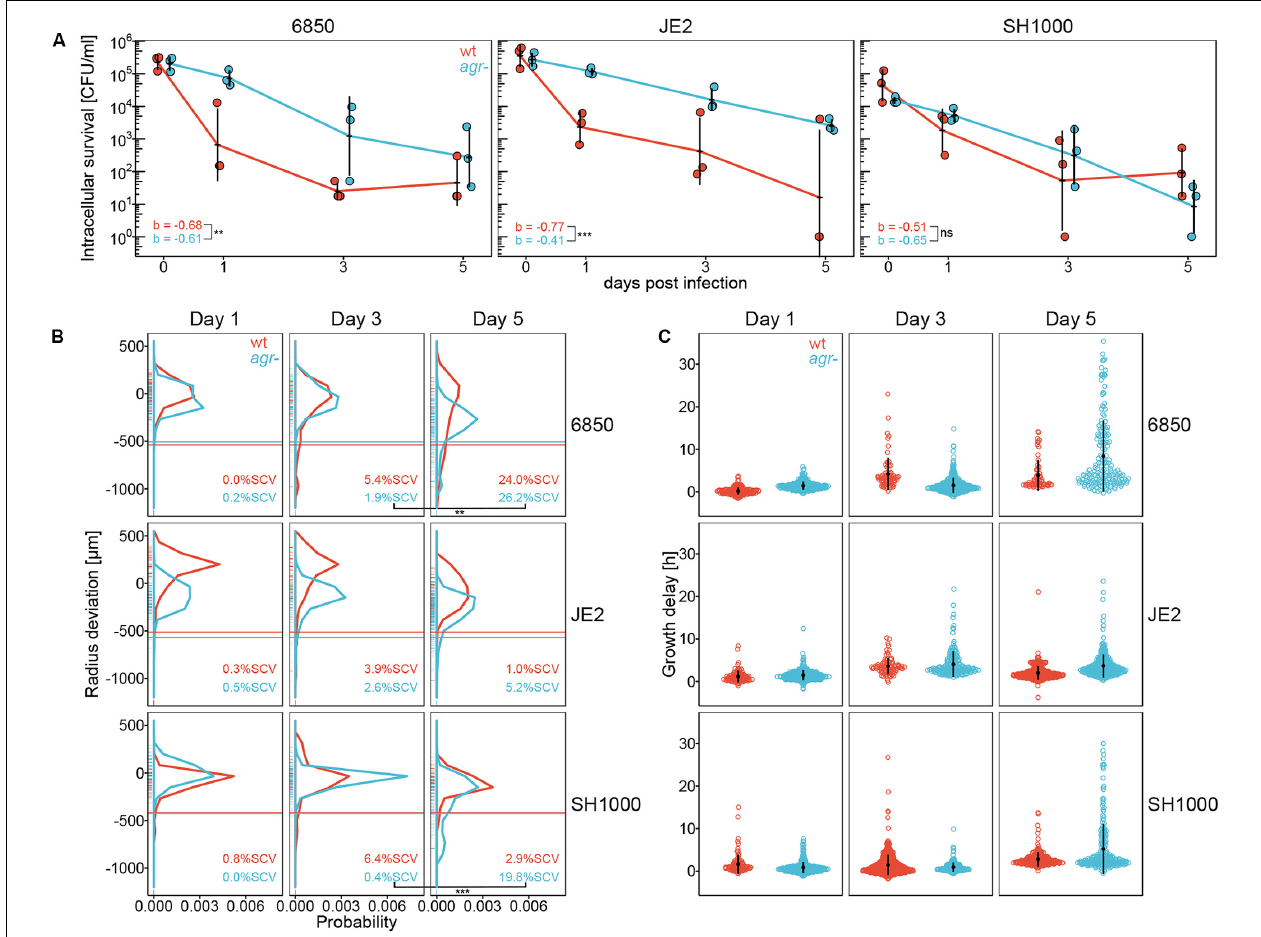
FIGURE 2 | Intracellular survival, colony size distribution and lag time of S. aureus wild type strains (wt) and agr mutants ( agr- ). S. aureus wild type strains are indicated in red, agr mutants are indicated in blue. (A) Intracellular survival of S. aureus wild type strains and agr mutants in A549 cells. Recovered bacteria are shown as CFU per ml in log scale over an infection period of 5 days. Data points of wild types and agr mutants are offset on x-axis for easier readability. Three independent experiments in technical triplicates ± SEM are shown. ** p = 0.0032, *** p = 0.0005. b indicates the slope of the curve. (B) Colony size distribution of recovered bacteria. After 24 h regrowth, colony radius is normalized to the strain specific mean colony area at day 0 ( Supplementary Figure 1 ). Radius size deviation from reference is plotted as probability density function. Individual colonies are shown as short lines on y-axis. The threshold for SCVs, indicated as a horizontal line, was calculated as 1/5th of the area of the median area at day 0. The mean percentage of SCVs is written in each panel. Colonies from single images as well as from time-lapse analysis were taken into account. In total 11,926 colonies in two to seven biological repeats were analyzed. ** p = 0.0024, *** p < 0.0001. (C) A subset of the colonies shown in B were monitored with time-lapse imaging on blood agar plates. Appearance time is normalized to the strain specific mean appearance time at day 0 ( Supplementary Figure 7 ). Growth delay is plotted as deviation from reference in hours. Every point of the dot plot represents one colony. In total 3,715 colonies in two to four biological repeats were analyzed. Colony radius at 24 h of time-lapse analysis is included in Figure 2B